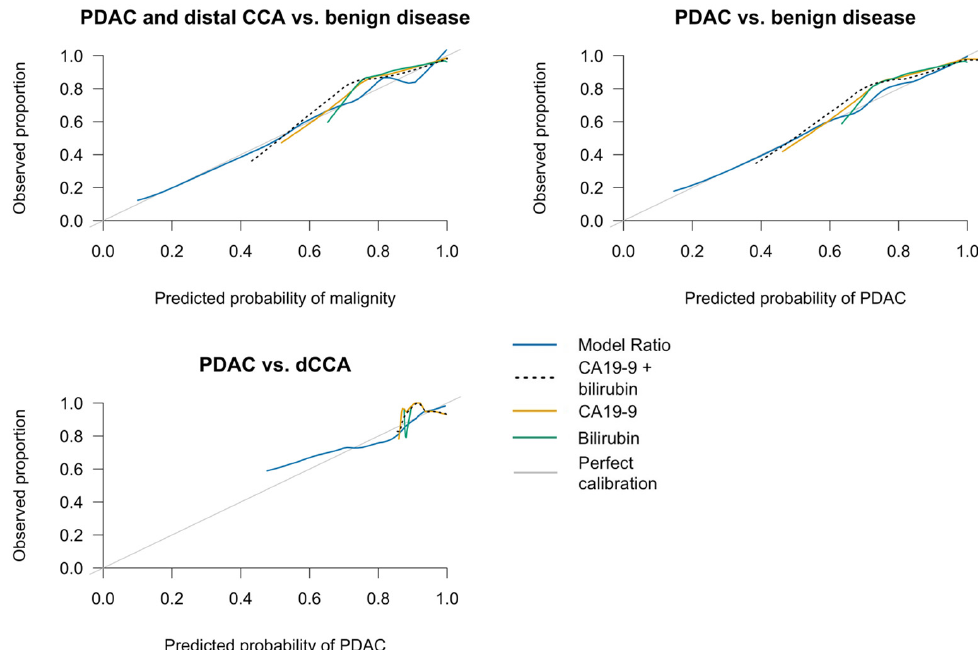
Figure 3. Overfitting-corrected calibration curve using a loess nonparametric smoother and 1000 bootstrap repetitions.